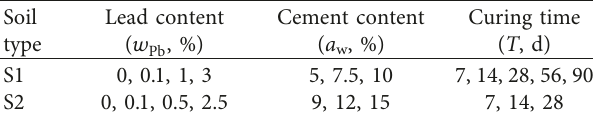
Figure 1: Grain size distribution curves of soils used in this study. Table 2: The lead content, cement content, and curing time for electrical resistivity measurement.